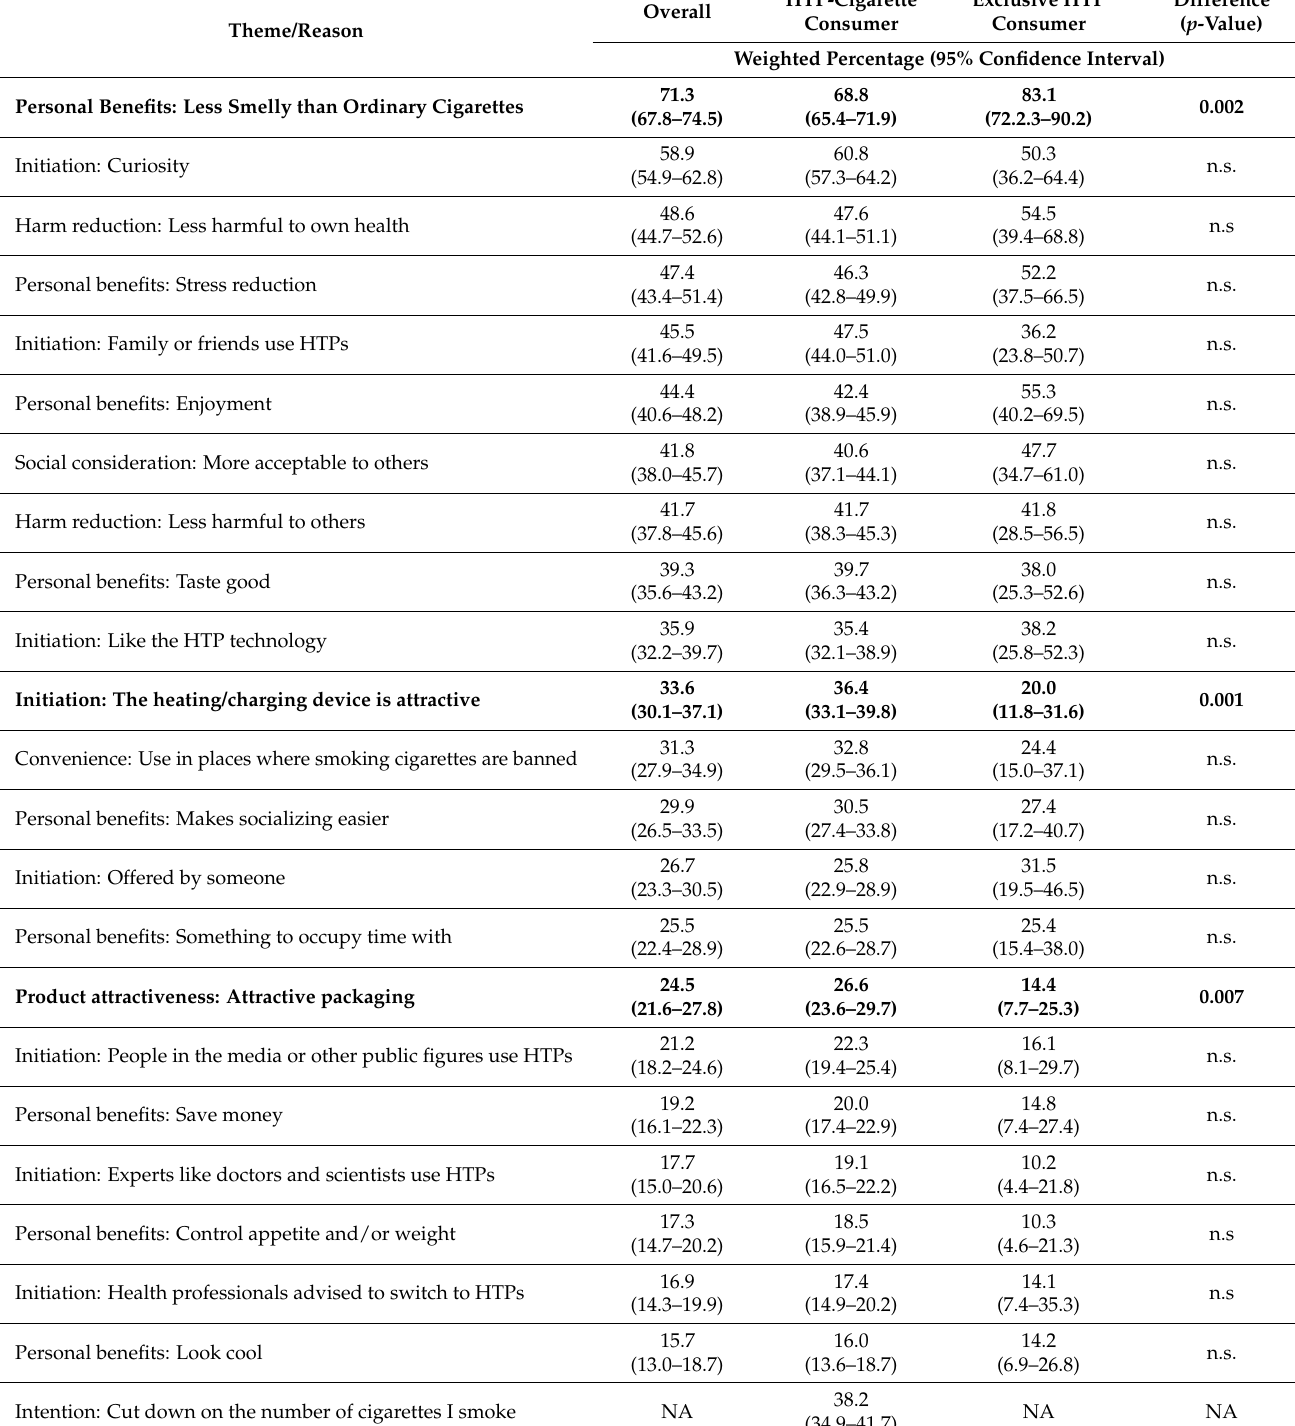
Table 3. Reasons for initiating and regularly using HTPs among HTP